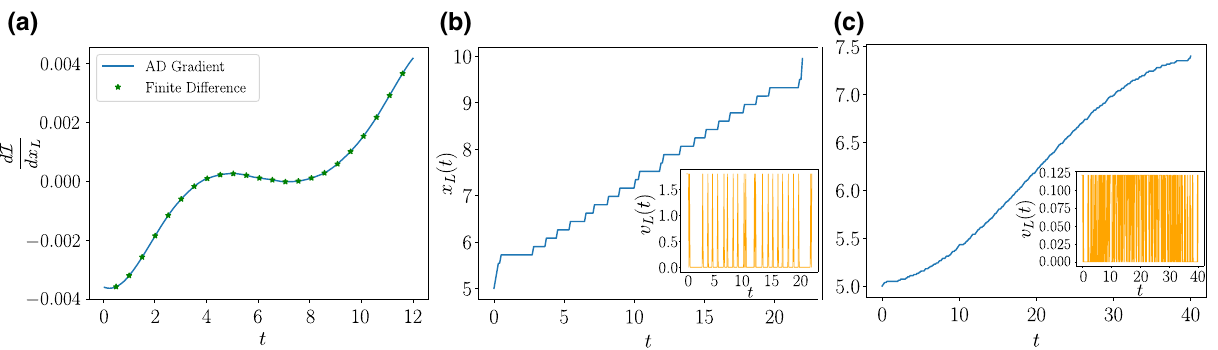
FIG. 11. (a) Comparison between the gradient of the infidelity I with respect to the control x L obtained with automatic differentiation (AD) and finite difference. The gradients d I / dx L are evaluated for a linear protocol x L ( t ) = v avg t as a function of time t in regime (I). The AD gradient matches up with the finite-difference gradient and we note that at the beginning and end of the protocol the magnitude of the gradient is the largest. (b),(c) Optimized parameterized bang-bang protocols in regimes (II) (b) and (IV) (c) with the simulated annealing method. The position profiles x L ( t ) are plotted in the main panels and the velocity profiles v L ( t ) in the insets. The bang-bang protocols seem to approximate the JMJ protocol in regime (II) and superadiabatic protocol in regime (IV). The parameters for these simulations are the same as in Fig. 2 in the main